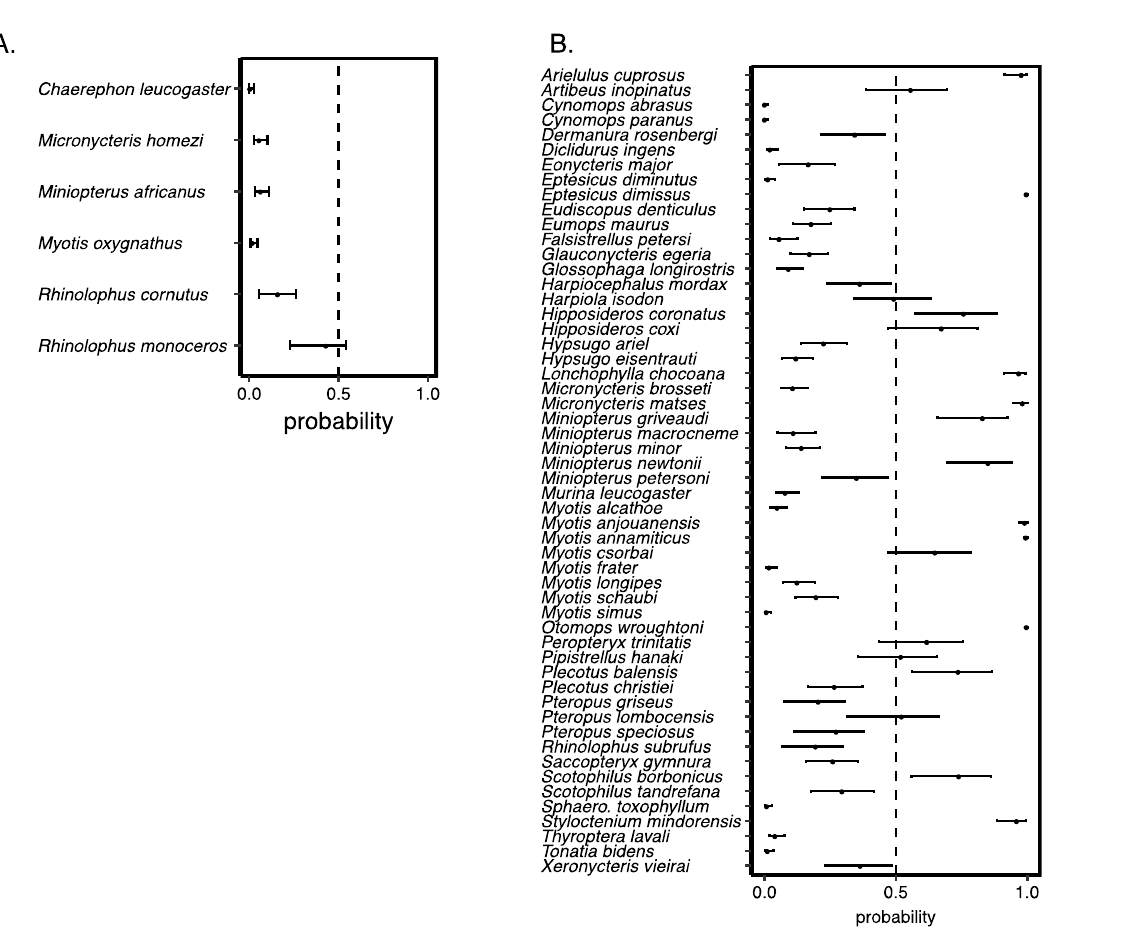
Figure 3. Estimated species threat given extinction risk estimates of the taxon-rich model simulations. 95% prediction intervals are shown. A species was considered threatened if its median estimate was greater than or equal to 0.50. Prediction intervals that overlap 0.5, demonstrate uncertainty of threat status given the model. ( A ) Species designate Not Evaluated (NE), and ( B ) species designated Data Deficient (DD) on the Red List.